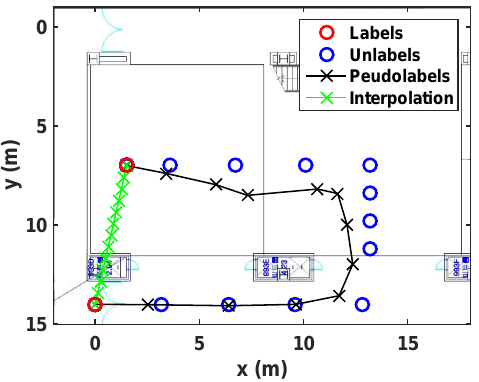
Figure 6. Estimated pseudolabels when revisiting the learned trajectory in comparison with the linear interpolation.